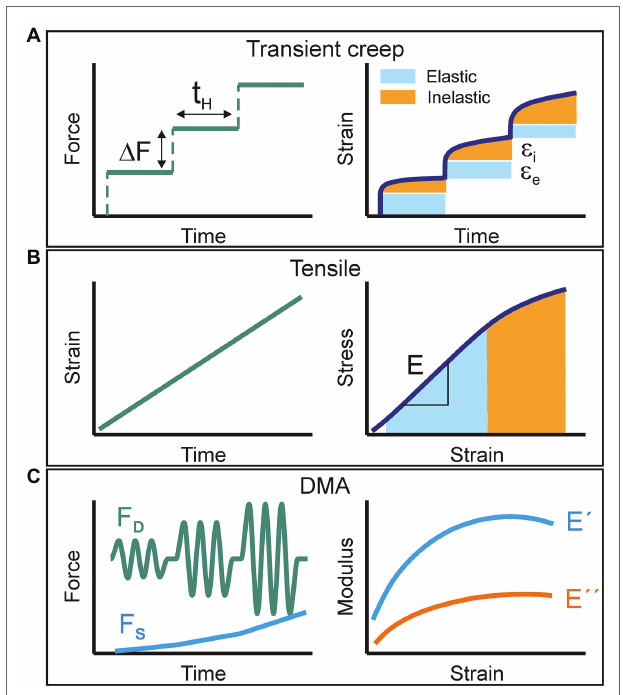
FIGURE 1 | Schematic representation of the mechanical characterization methods used in this study: (A) transient creep, (B) uniaxial tensile, and (C) multi strain dynamic mechanical analysis. The applied perturbation signal is shown on the left side while the collected response is plotted on the right.